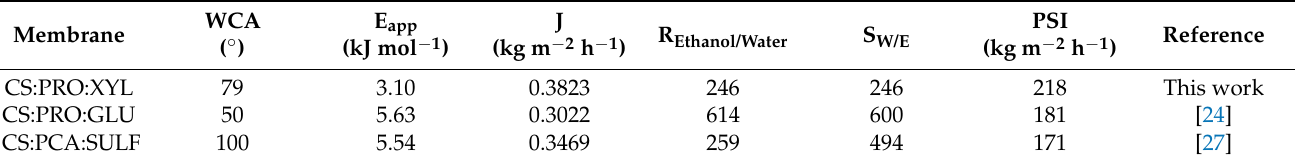
Table 3. Comparison of the DES-containing CS membrane parameters and separation performance at 30 ◦